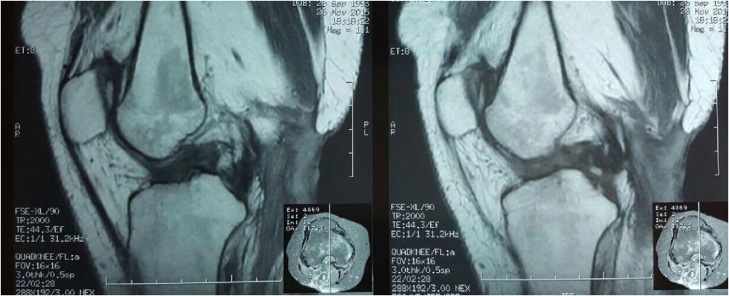
MRI T2-weighted.